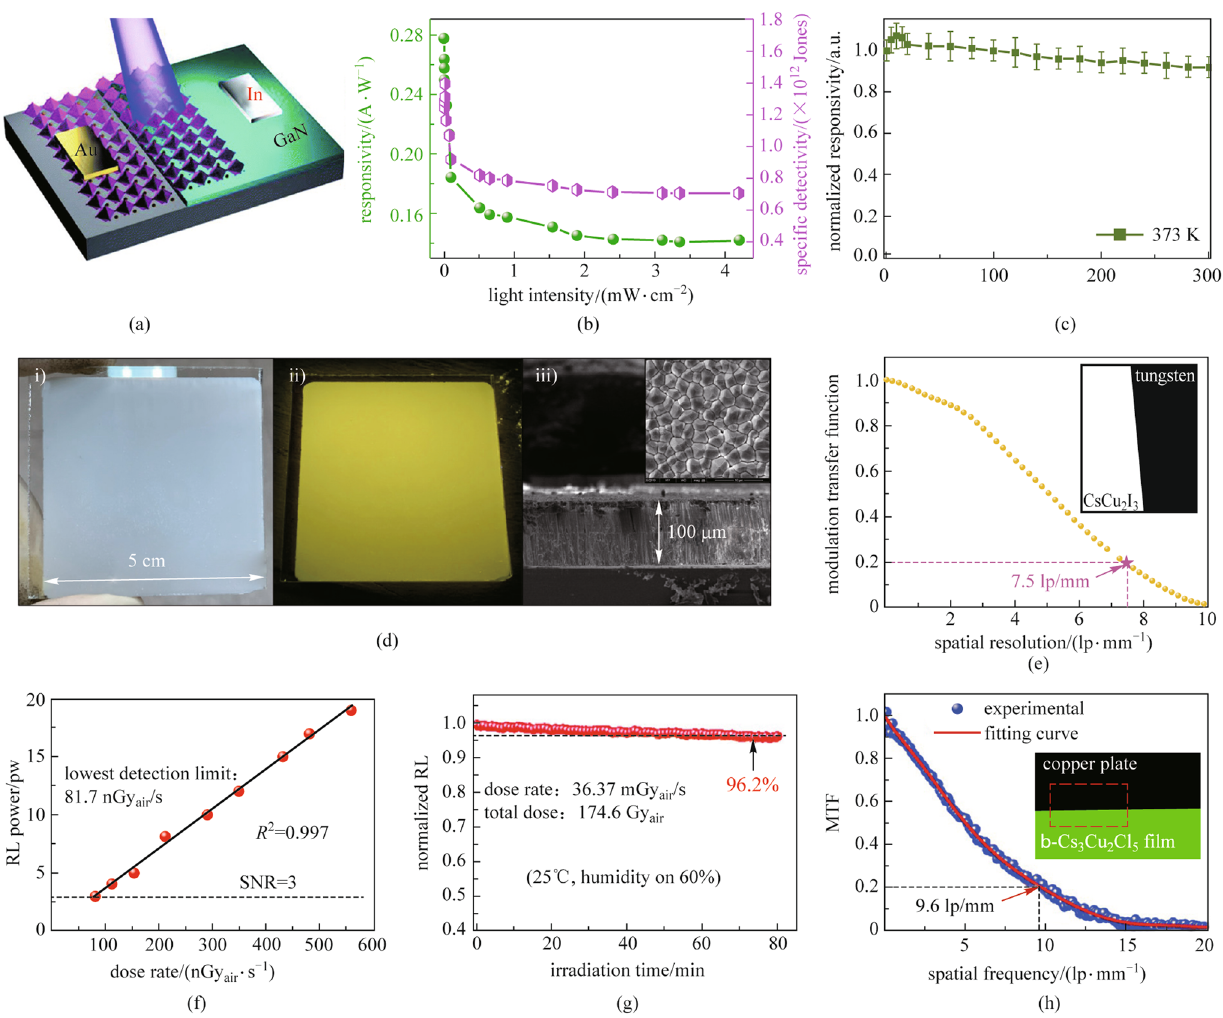
Fig. 5 a Schematic illustration of the Cs 3 Cu 2 I 5 /GaN heterojunction device; b Responsivity and specific detectivity of the photodetector versus light intensity; c Responsivity evolution of the heterojunction photodetector monitored at 373 K in ambient air. a – c Reprinted with permission from Ref. [59], Copyright 2020, Royal Society of Chemistry; d CsCu 2 I 3 film for the X-ray imaging application: (i) Optical photograph, (ii) pho- toluminescent photograph, and (iii) SEM image of oriented structured CsCu 2 I 3 thick film; e Modulation transfer function (MTF) of the CsCu 2 I 3 detector, measured by the slanted-edge method (inset). d , e Reprinted with permission from Ref. [62], Copyright 2021, American Chemical Society; f Lowest detection limit of Cs 3 Cu 2 Cl 5 films at signal noise ratio (SNR) of 3; g Operational stability of Cs 3 Cu 2 Cl 5 films by continuous X-ray irradiation; h MTF of